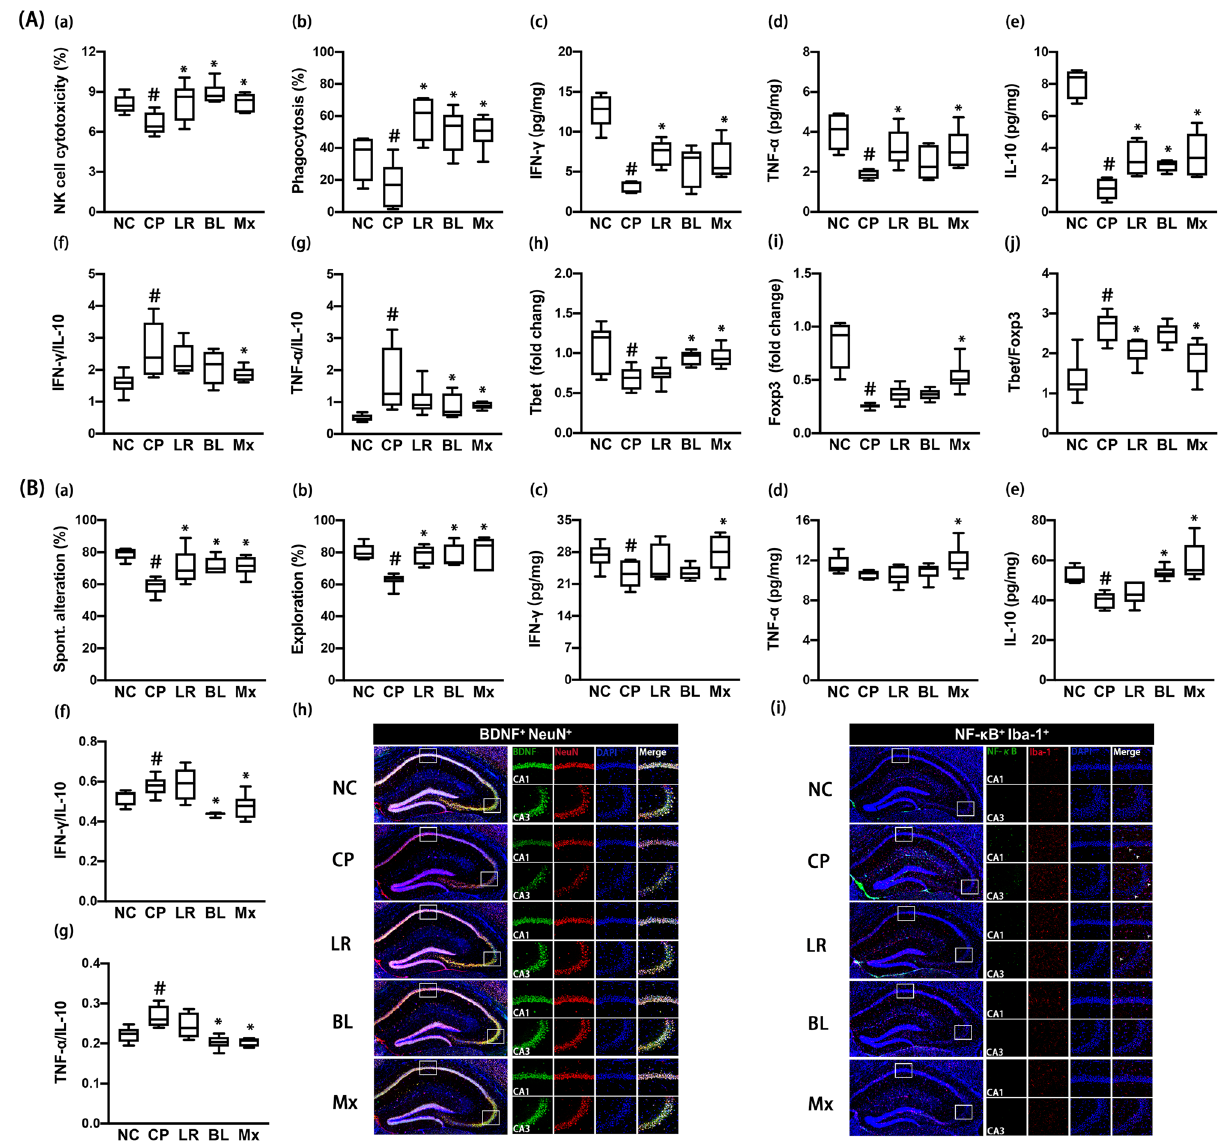
Figure 5. Effects of NK210 and NK219 on cyclophosphamide-induced immune imbalance and cognitive impairment in mice. ( A ) Effects on the immune imbalance: splenic NK cell cytotoxicity activities (a), peritoneal macrophage phagocytosis (b), IFN-γ (c), TNF-α (d), and IL-10 expression (e), IFN-γ to IL-10 expression ratio (f), TNF-α to IL-10 expression ratio (g), Tbet (h) and Foxp3 expression (i), and Tbet to Foxp3 expression ratio (j) in the spleen. ( B ) Effects on cognitive impairment in the Y-maze (a) and NOR task (b). Effects on neuroinflammation: IFN-γ (c), TNF-α (d), IL-10 expression (e), IFN-γ to IL-10 expression ratio (f), TNF-α to IL-10 expression ratio (g), and BDNF + /NeuN + (h) and NF-κB + /Iba1 + cell populations (i) in the hippocampus. Test agents (CP, cyclophosphamide alone; LR, 1 × 10 9 CFU/mouse/day of NK210; BL, 1 × 10 9 CFU/mouse/ day of NK219; Mx, 1 × 10 9 CFU/mouse/day of LR and BL [4:1] mix) were orally gavaged daily for 5 days after intraperitoneal injection of cyclophosphamide. Normal control mice (NC) were treated with vehicle (saline) instead of test agents. Data values indicate mean ± SD (n = 8). # p < 0.05 versus NC group. * p < 0.05 versus CP group treated with cyclophosphamide population increased. When the correlation between gut microbiota populations and IFN-γ to IL-10 or Tbet to Foxp3 expression ratio was analyzed in the gut and spleen, Ternericutes population (R = 0.51, p = 0.011) was positively correlated with the Tbet to Foxp3 expression ratio at the phylum level, Firmicutes, Protoebacteria, and Bacteroidetes populations were not correlated with the IFN-γ to IL-10 or Tbet to Foxp3 expression ratio (Fig. 8C).